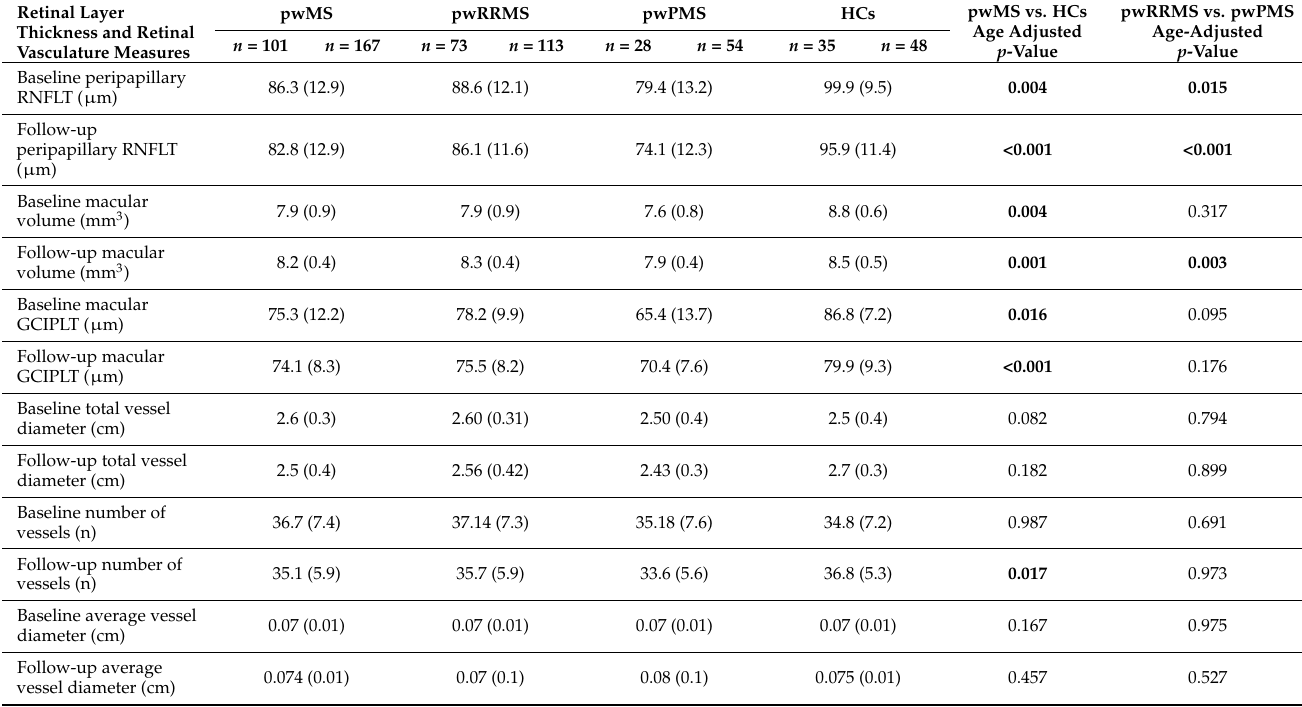
Table 3. Retinal layer thickness and retinal vasculature measures in the study population at their study